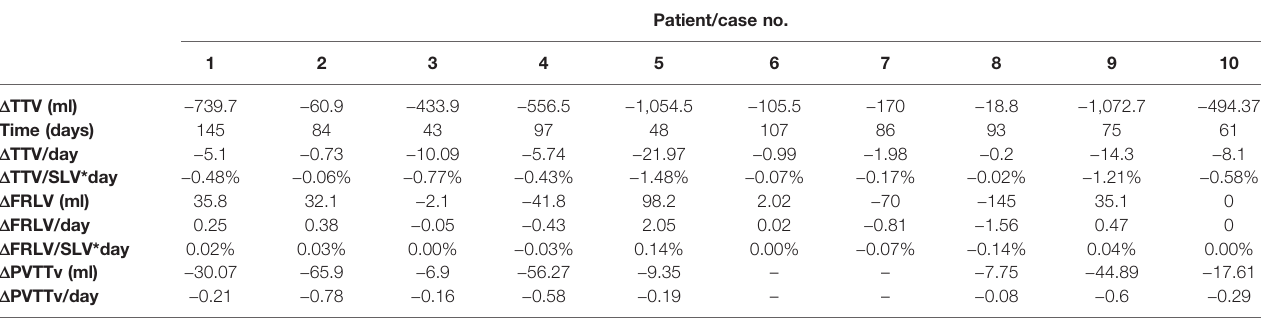
TABLE 2 | Change in tumor characteristics before vs . after the combined therapy.